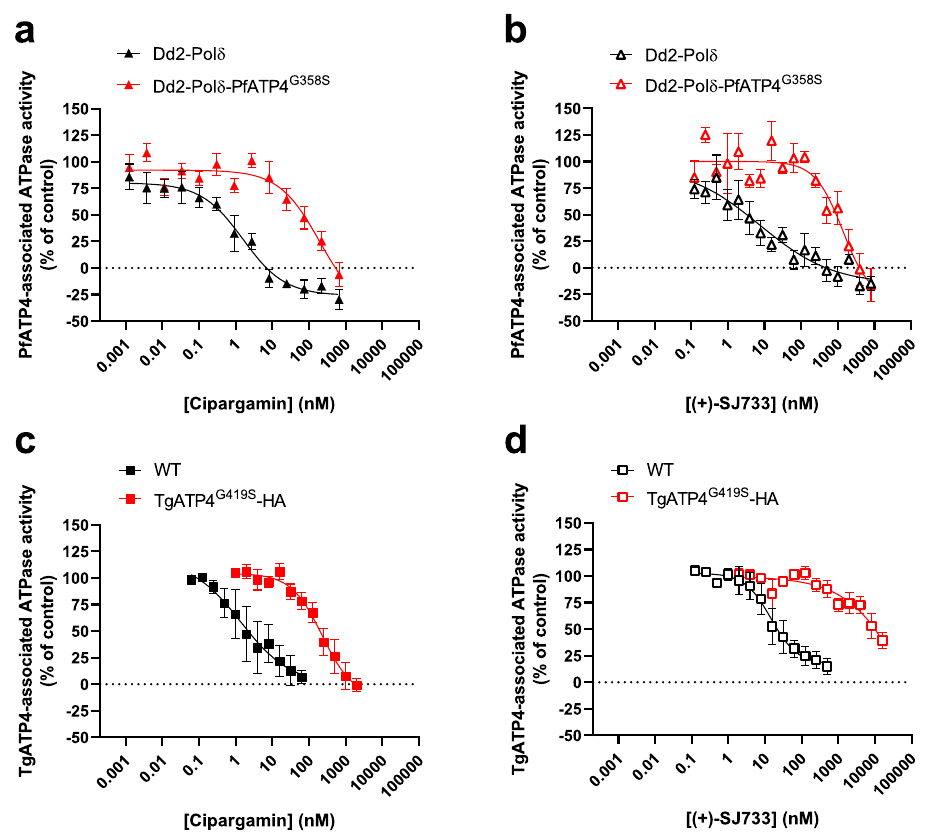
the mean (± SEM) from the following number of independent experiments (each performed on different days with different membrane preparations):4 ( a ), 3 ( b ), 4 ( d ).Where not shown, error bars fall within the symbols. Source data are provided as a Source Data fi